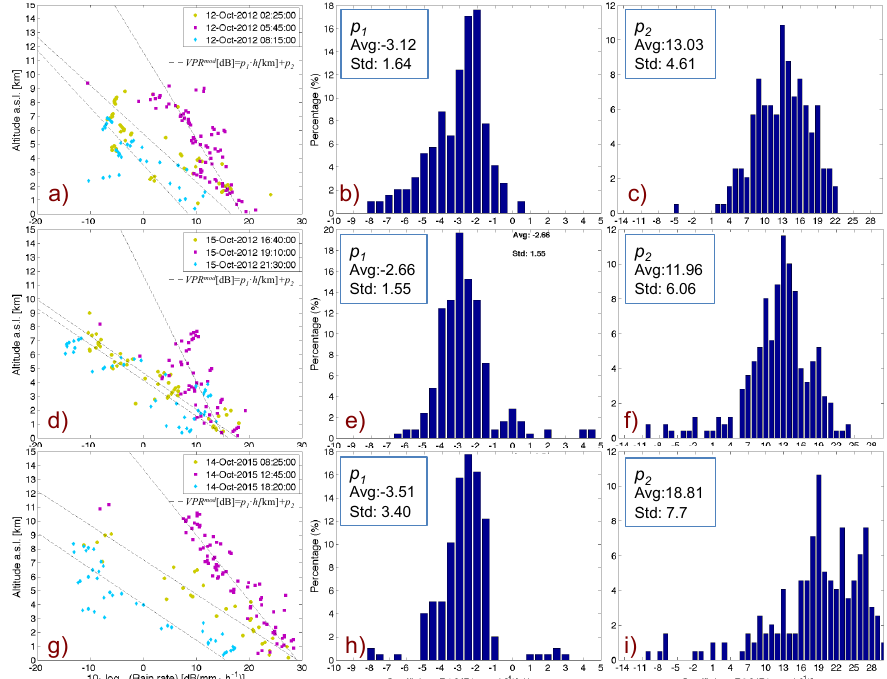
Figure 5. ( a , d , g ) Examples of quasi Vertical Profiles of rain rate intensity (VPR) as a function of altitude ( h ) at the time specified in the panel’s legend for the case studies on 12 October 2012, 15 October 2012 and 14 October 2015, respectively. In this figure R KZ is used to calculate VPR. The dotted straight lines refer to linear regressions in the form VPR m o d (dB) = p 1 · h (km) + p 2 ; ( b , c , e , f , h , i ): statistical distribution of the parameters p 1 and p 2 , respectively, extracted from the P55C in each of the three case studies considered. The values of average and standard deviation for p 1 and p 2 are also shown in the panel’s legend. To pair the radar estimates and gauge observations, we considered the median of the values of radar hourly accumulations within a circular domain around each rain gauge position. Such choice should smooth the effects due to the time delay needed for the water to fall to the ground as well as the area to point mismatches between the two measurements. The ray of the circular domain is set to 5 km, consistent with typical values of drop fall velocity and horizontal movements of storms. Note